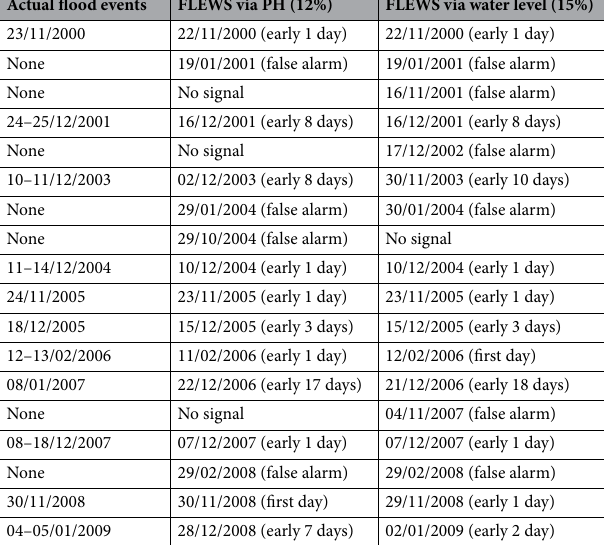
1 norm of the zero-dimensional persistence landscapes